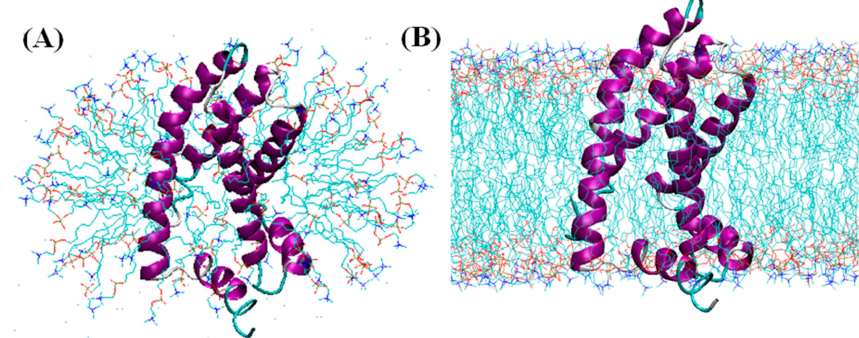
Figure 1. Cartoon representation of an example of the membrane protein human KCNQ1 voltage sensing domain (KCNQ1- VSD) (PDB ID: 6MIE) incorporated into detergent micelles (Dodecylphosphocholine (DPC)) ( A ), and lipid bilayers (1,2- Dimyristoyl-sn-glycero-3-phosphocholine (DMPC)) ( B ). Image was prepared using visual molecular dynamics (VMD) [33] and molecular modeling was performed using CHARMM-GUI (http://www.charmm-gui.org, accessed on 18 December 2020)